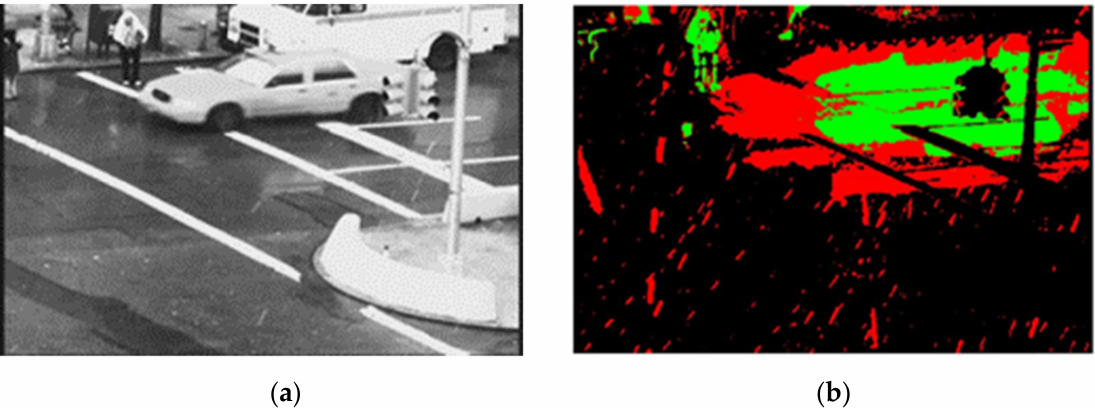
Figure 5. ( a ) Input frame 79 and ( b ) Mask of 79th frame represents background, rain streaks and moving objects of video sequence “Traffic” where black, green and red colours represent background, object, and rain streaks areas,